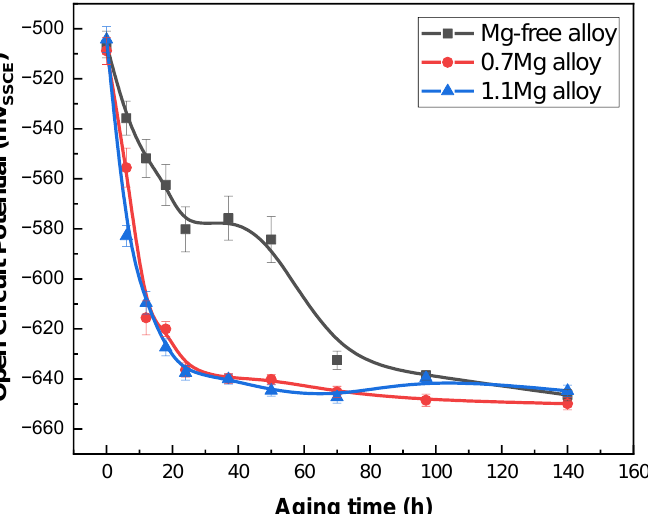
Figure 1. Open circuit potential of Al – Cu – Li alloys with different Mg content after aging at 150 °C for 0–140 h.